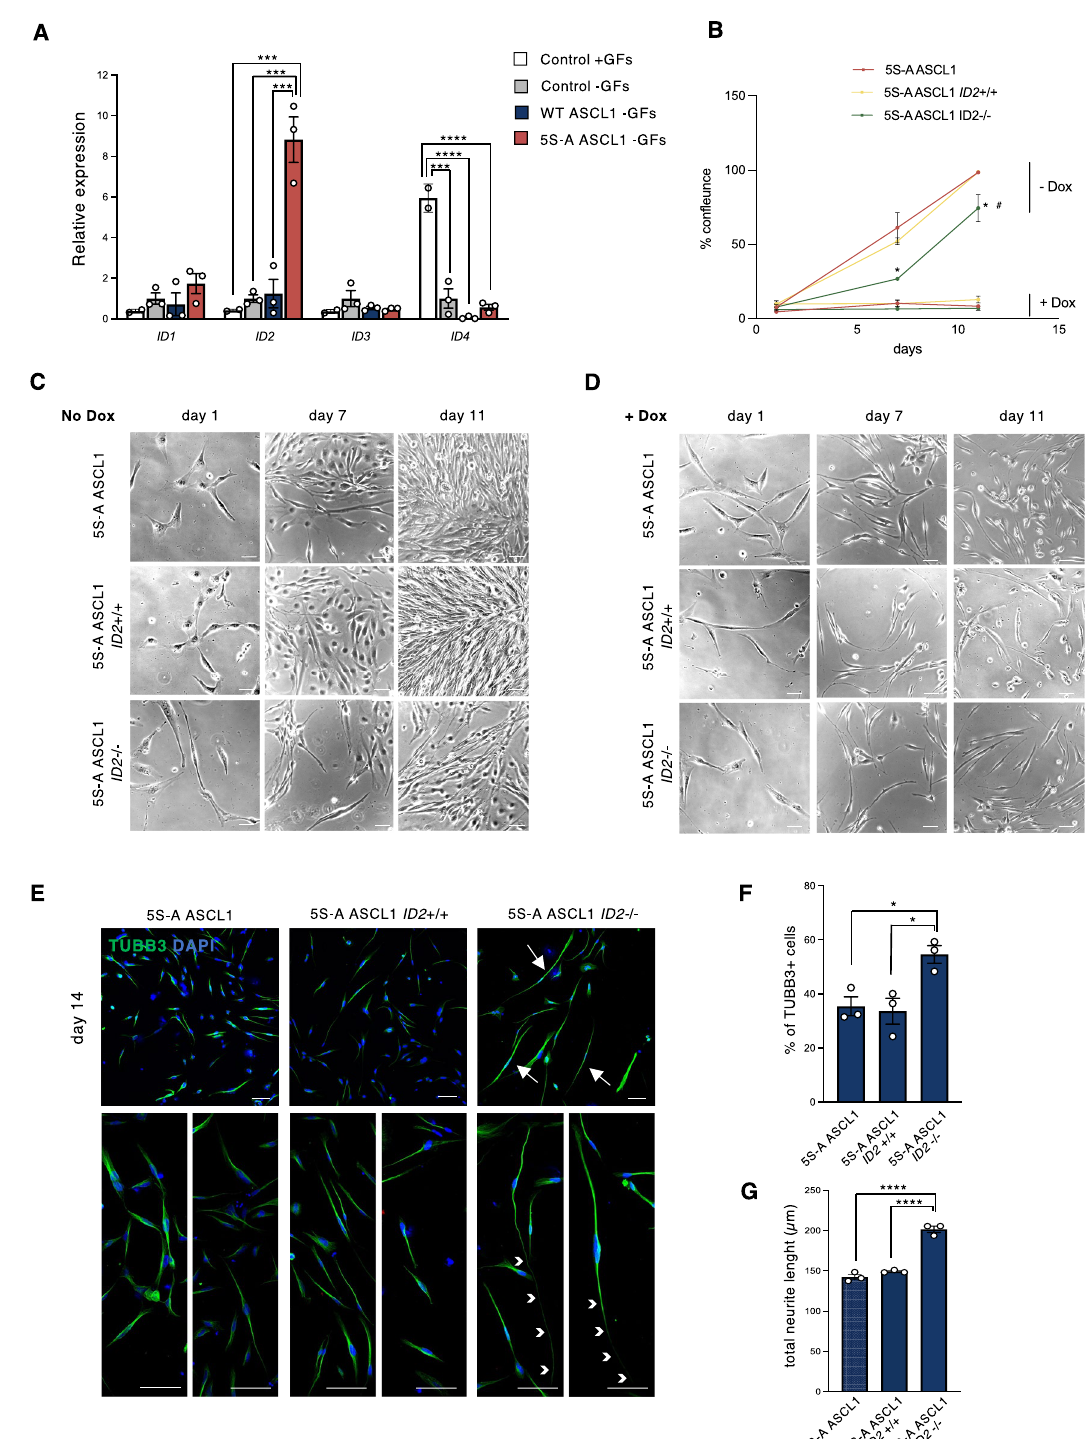
Figure 4. ID2 restrains differentiation induced by dephosphorylated ASCL1. ( A ) Relative mRNA expression of different members of the ID family at 7 days after WT and 5S-A ASCL1 expression. Data: mean ± SEM, normalized to TBP . n = 3 independent experiments; one-way ANOVA followed by the Bonferroni post-hoc test; *** p < 0.001; **** p < 0.0001. ( B ) Quantification of cell confluence. Each data point is mean ± SEM n = 3 independent experiments; one-way ANOVA followed by the Bonferroni post-hoc test; * p ≤ 0.05 between ID2 −/− and 5SA-ASCL1; # p ≤ 0.05 between ID2 −/− and ID2 +/+ . ( C , D ) Representative images of unedited control cells, ID2 wild type cells and ID2 homozygous knock-out cells, without ( C ) or with ( D ) dox-induced ASCL1 expression at increasing time points, as labelled. Scale bars: 100 μm. ( E ) Immunostaining for neuronal marker TUBB3 (green) at 14 days of culture in differentiation conditions. Scale bars: 100 μm. ( F ) Quantification of the % of TUBB3 + cells over the total DAPI + cells at day 14. Data: mean ± SEM n = 3 independent experiments; one-way ANOVA followed by the Bonferroni post-hoc test; * p < 0.05. ( H ) Quantification of the total neurite length per cell. Data: mean ± SEM n = 3 independent experiments; one-way ANOVA followed by the Bonferroni post-hoc test; **** p <